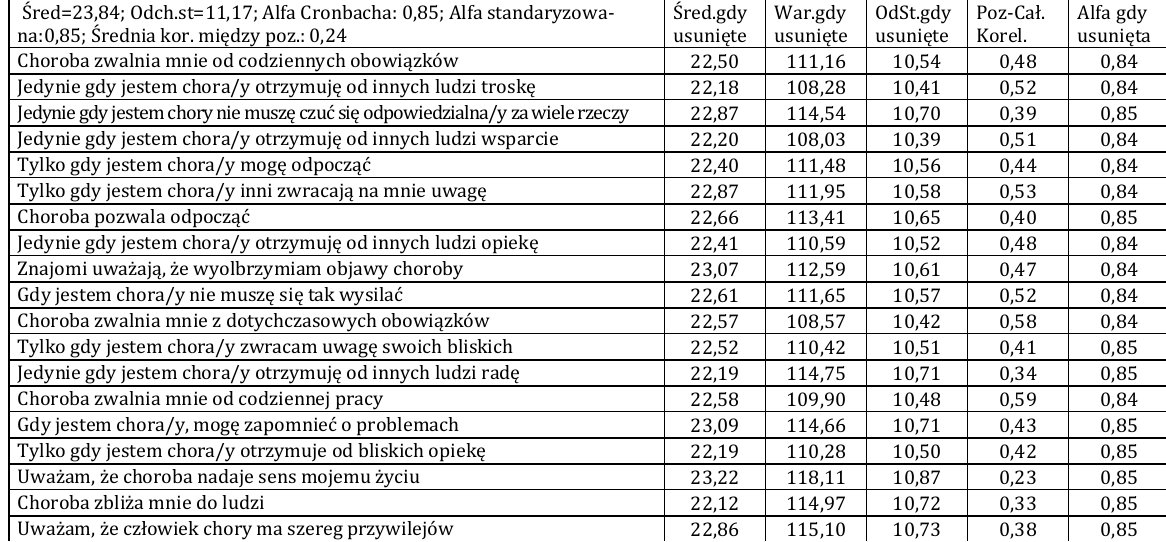
Tab. 5. Wyniki średnie, odchylenia standardowe oraz współczynniki rzetelności alfa Cronbacha dla całej skali oraz dla poszczególnych itemów tworzących skalę nazwaną – Choroba jako korzyść Śred=23,84; Odch.st=11,17; Alfa Cronbacha: 0,85; Alfa standaryzowa- na:0,85; Średnia kor. między poz.: